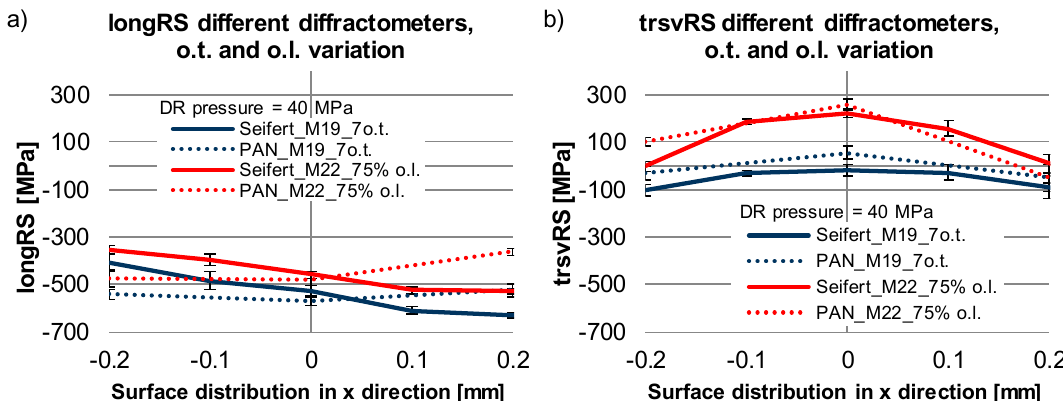
Figure 5. In-trace residual stress surface distribution of milled and DR state (designation M), by variation of the measurement devices (Seifert XRD 3000 PTS or PANalytical Empyrean), the overturn (o.t.) and the overlapping (o.l.) parameters; ( a ) longitudinal residual stresses (longRS) and ( b ) transverse residual stresses (trsvRS).